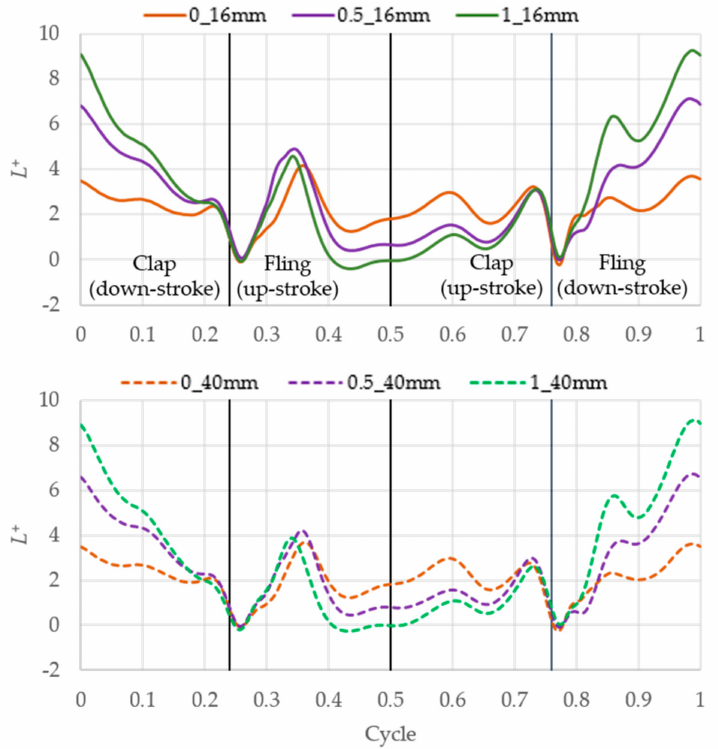
Figure 13. Non-dimensional lift in various inflow